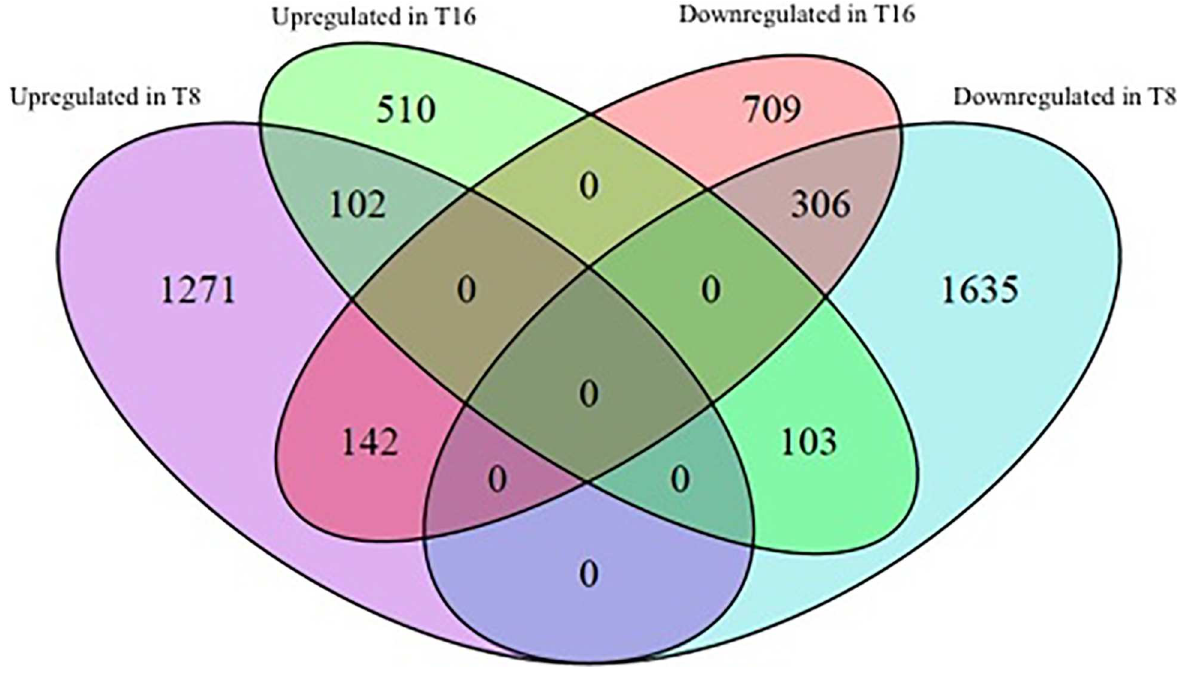
Fig 1. Venn diagram of total DEGs and overlapping DEGs (log 2 fold change > +1 or < -1, P value < 0.05).